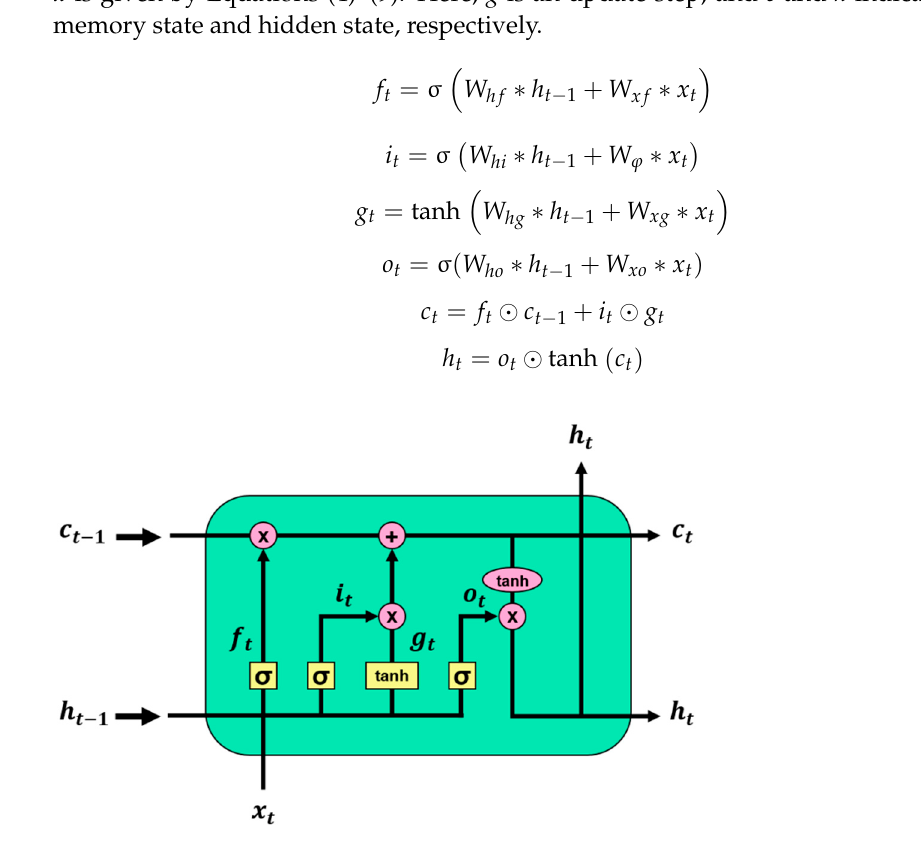
Figure 5. Architecture of long short-term memory.